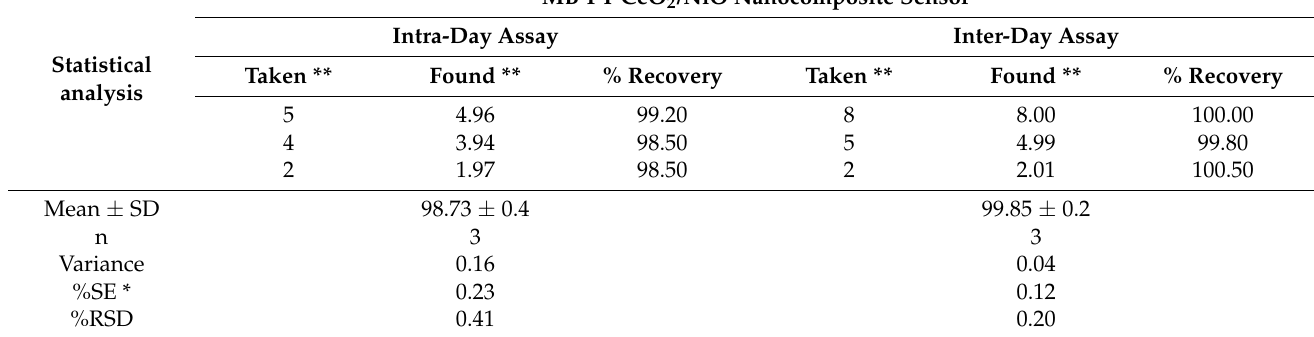
Table 5. Precision outcomes estimated from the determination of three MB solutions using MB-PT- CeO 2 /NiO nanocomposite